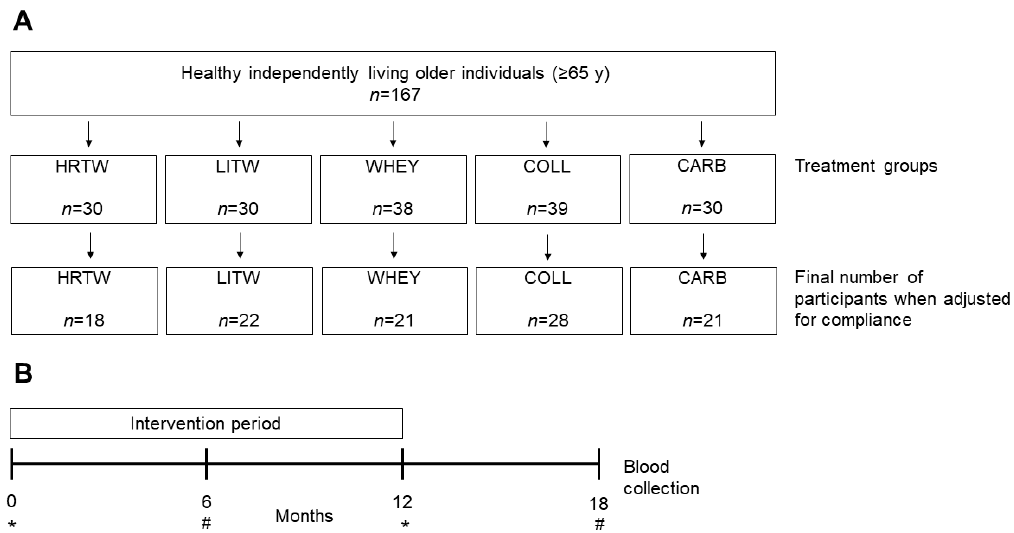
Figure 1. Study design. ( A ) Healthy home-dwelling older individuals were included in the study. The participants were divided in five groups who received two daily nutrient supplements with either whey (WHEY), collagen (COLL), or carbohydrates (CARB) without training intervention or whey supplementation in combination with different training schemes. The heavy resistance training (HRTW) group performed supervised heavy resistance training three times per week in a fitness center. The light resistance training (LITW) group performed supervised home-based light resistance training three-to-five times per week. For the longitudinal part of the study, we included data from participants in the nutrition-only groups (WHEY, COLL, and CARB) with adherence ≥ 50% and with training adherence in the HRTW and LITW groups of ≥ 66% and ≥ 75%, respectively. In the text, the term “WHEY-ALL” is used for the HRTW, LITW, and WHEY groups combined. ( B ) Blood was collected at baseline (fasted (*)) and after six mo (non-fasted (#)) and 12 mo (fasted (*)) of intervention and again after a six mo follow-up period (18-mo) (non-fasted (#)) and measured for B12 biomarkers.